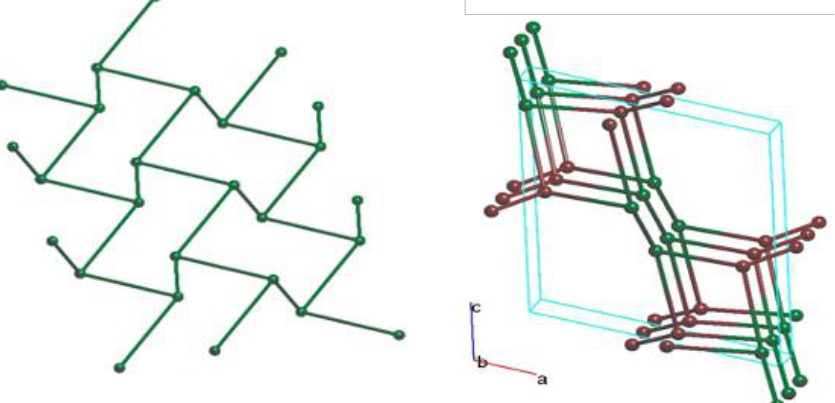
Figure 3. Representation of the repeating unit ( left ) and a part of the 2D network of 3 ( right ). Colour code: Cu, green; N, blue; O, red; C, grey. The hydrogen atoms are omitted for clarity.